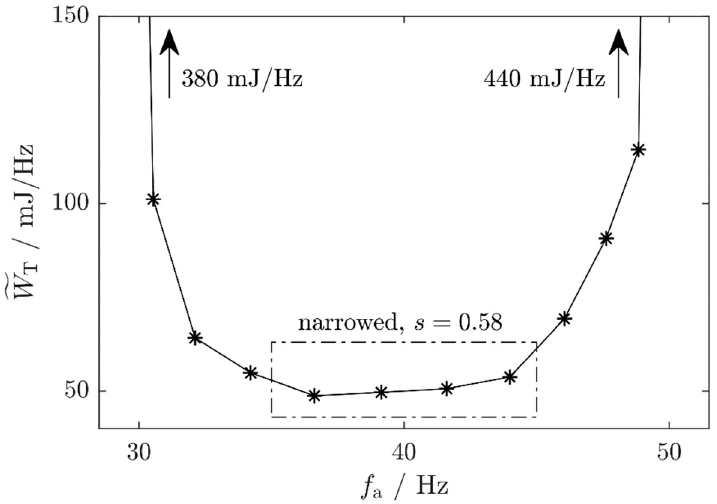
Figure 14. The adjustment energy per frequency interval, (cid:101) W T ( f ) , for the harvester used as validation case (computed from data in Ref. [25]). The dash-dotted rectangle marks the frequencies to which the adjustment with the ABS factor s = 0.58 was allowed.